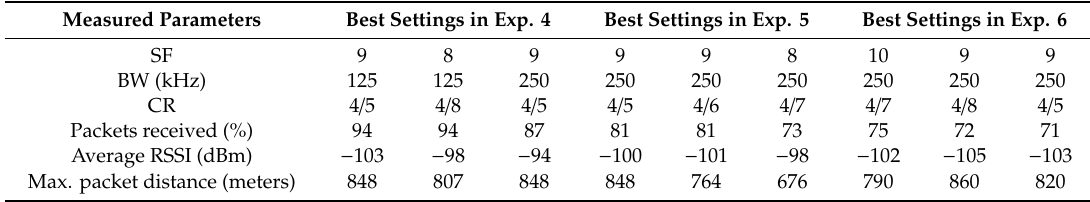
Table 5. Best settings in Experiments 4, 5, and 6